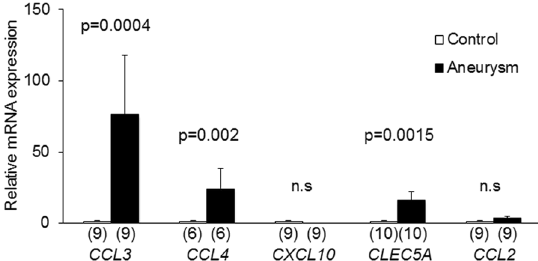
Figure 2. Induction of CCL3 , CCL4 , CLEC5A mRNA expression in intracranial aneurysm lesions. Total RNA was purified from dissected control arterial walls and intracranial aneurysm lesions and mRNA expressions of CCL3 , CCL4 , CXCL10 , CLEC5A and CCL2 were examined by quantitative RT-PCR analysis. The numbers of specimens analyzed are shown in parentheses. Statistical analysis was performed using a Mann-Whitney test. All bars indicate mean ± SEM. n.s; statistically not significant.